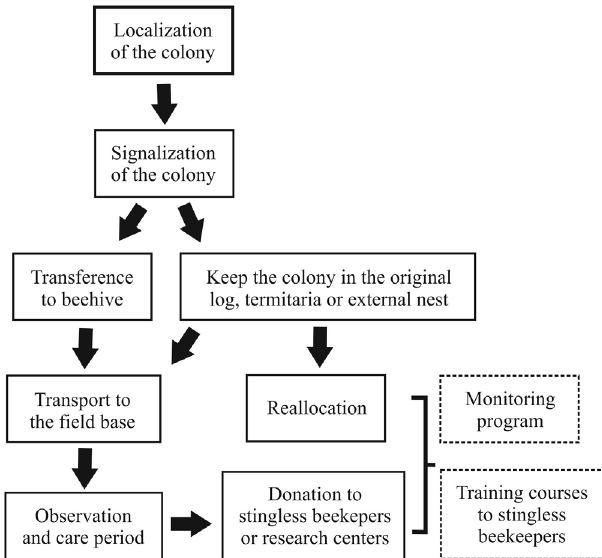
Fig 1. Diagram of steps adopted for the rescue of stingless bees during the deforestation to build the Santo Antonio hydroelectric power plant on the margin of the Madeira River and suggested post rescue actions (squares surrounded by dotted